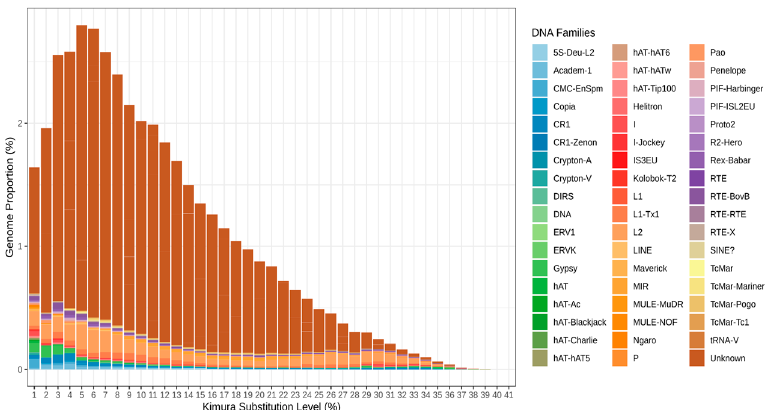
Figure 2. Interspersed repeat landscape in the Strongylocentrotus purpuratus genome. TE classes are marked with colors: SINEs, blue; LINE, red; LTR TE, yellow; DNA transposons, green; non-annotated repeats, brown.